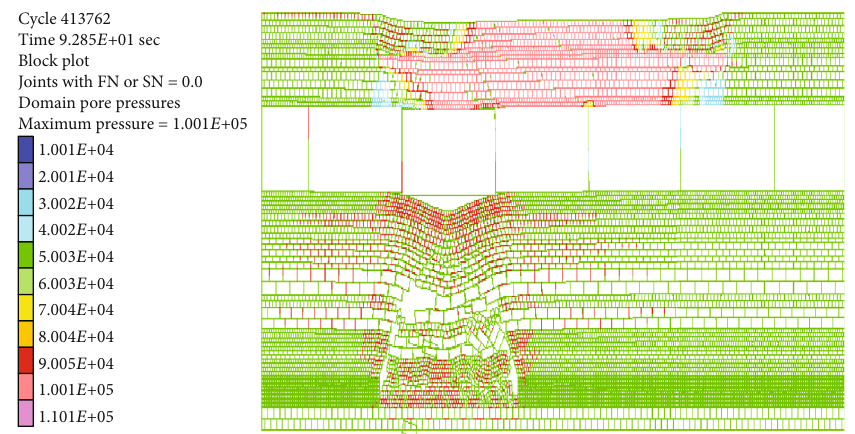
Figure 6: The pore pressure distribution in initial caving of #2 key stratum.